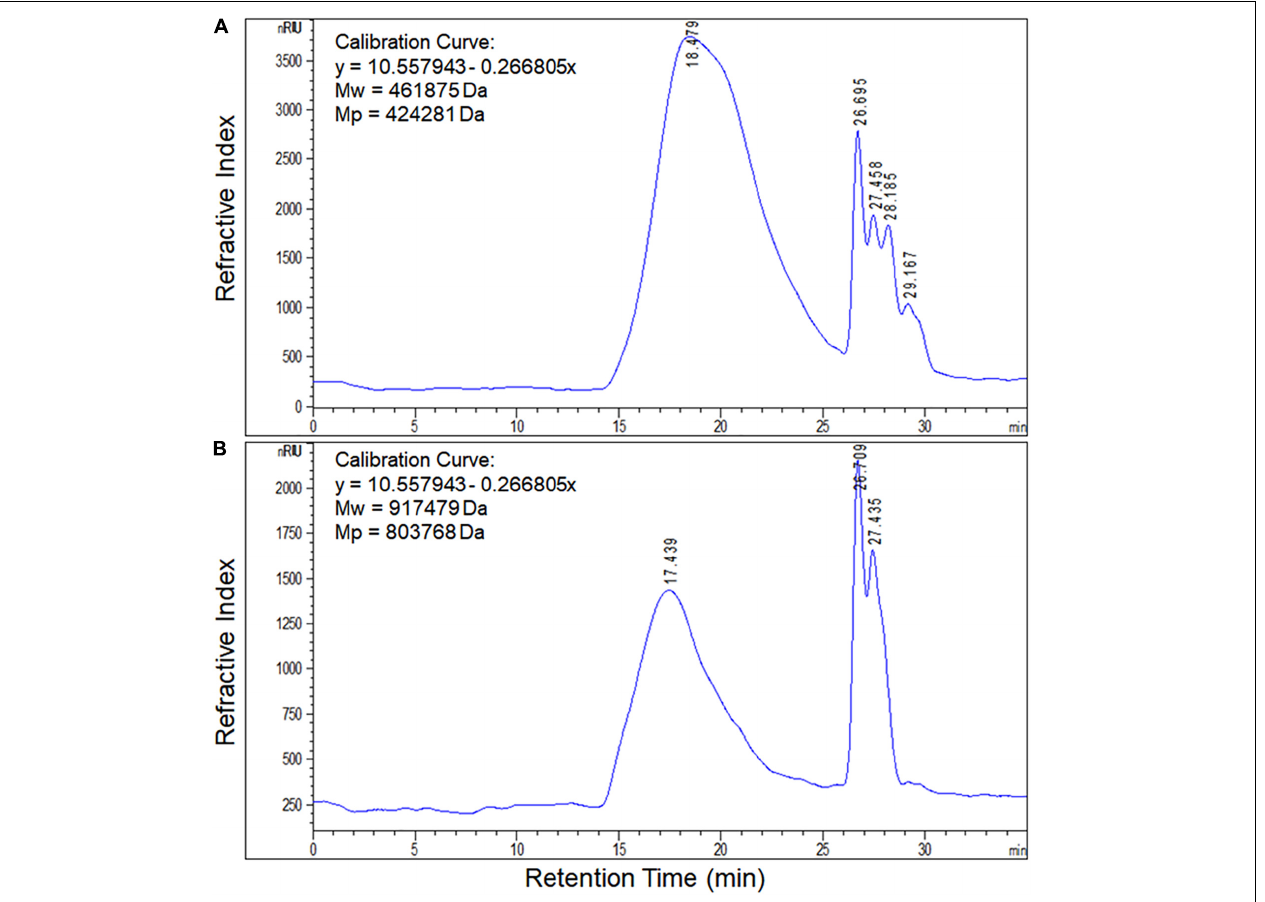
FIGURE 3 | Molecular weight of EPS produced by S. thermophilus 05epsC (A) and 05CK (B) . According to the linear regression equation drawn through dextran standards, the molecular weight of EPS samples was determined based on their retention time (X-axis) using gel permeation chromatography (GPC). Calibration curve was y = 10.557943 – 0.266805x. Mw, Average molecular weight; Mp, Peak molecular weight.